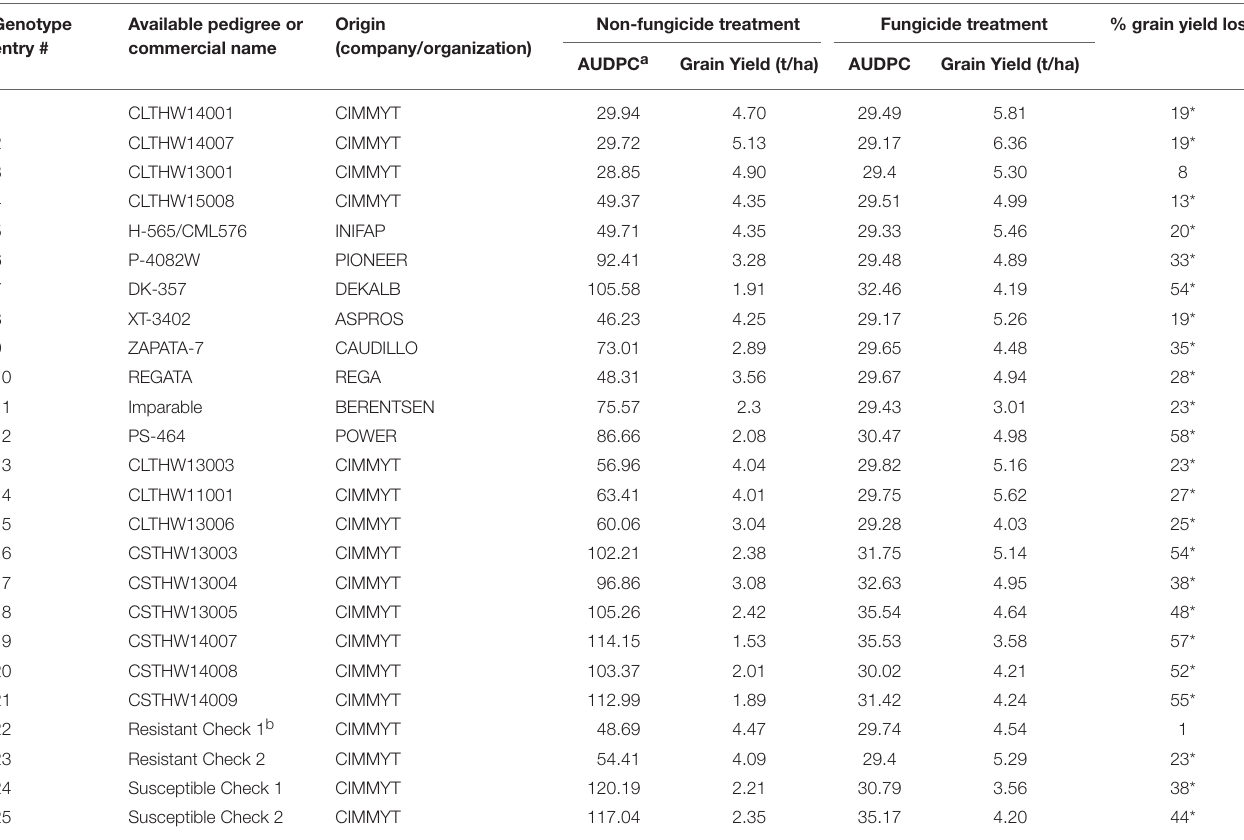
TABLE 1 | Grain yield loss caused by tar spot complex of maize calculated as the percentage difference of grain yield (t/ha) between fungicide and non-fungicide treatments over 2016 and 2017 growing cycles at the International Maize and Wheat Improvement Center (CIMMYT), Mexico. Genotype entry